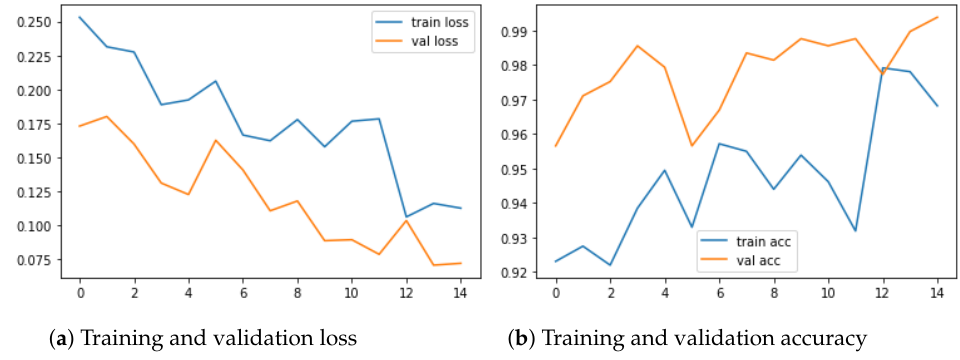
Figure 7. Classification performance of the VGG19